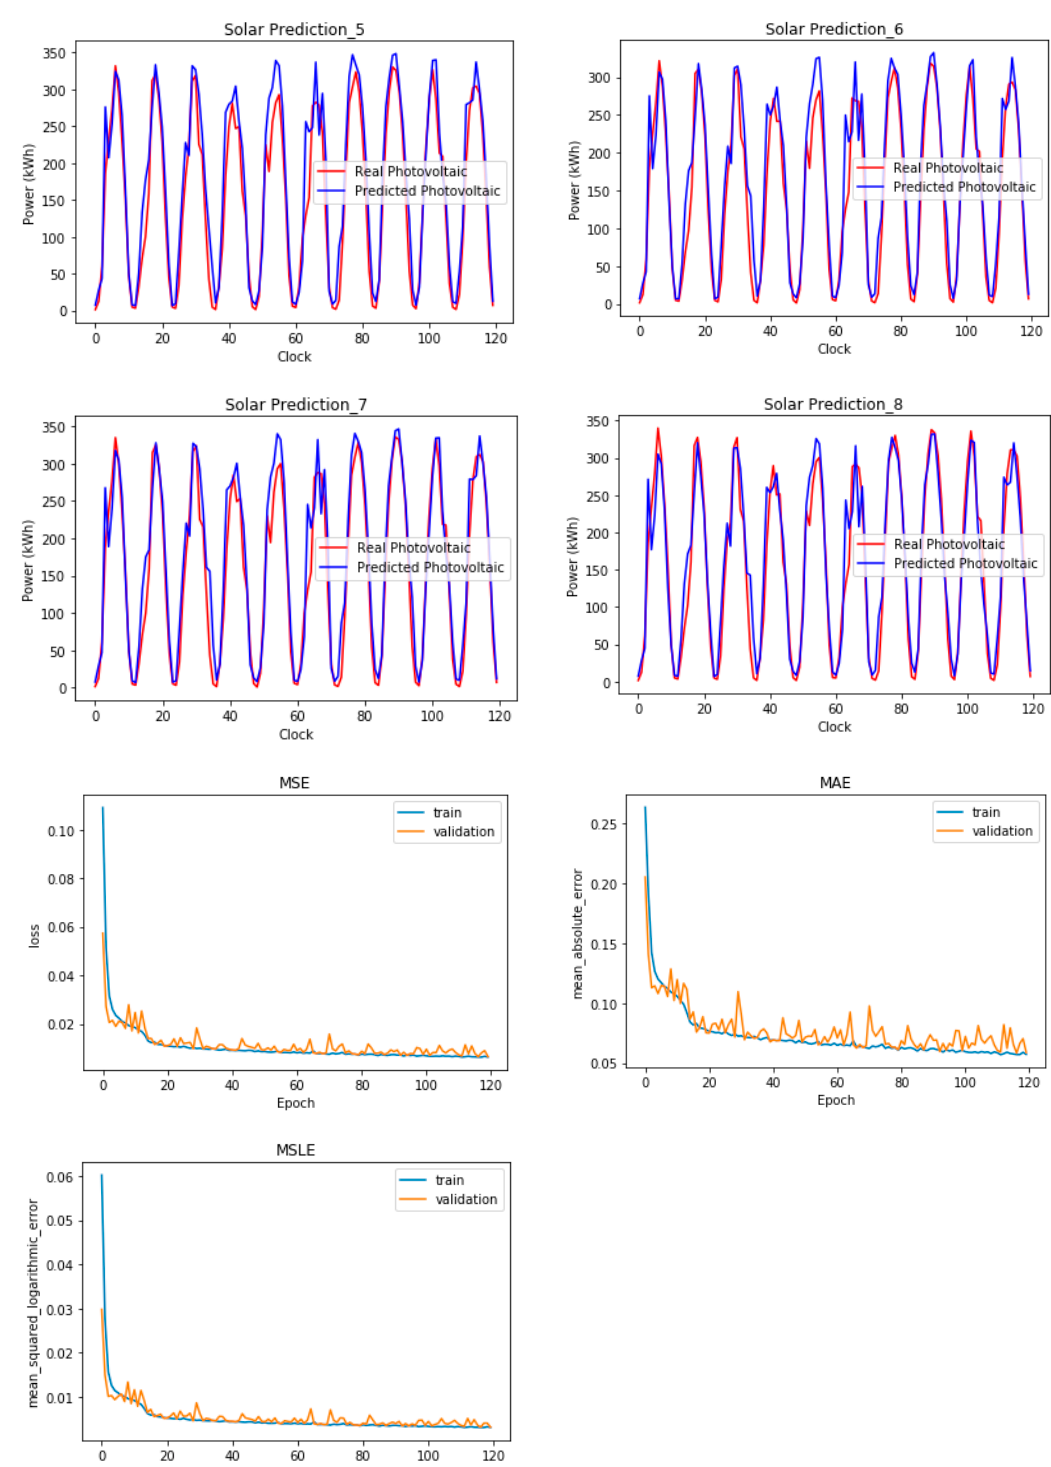
Figure 4. Multiple inverters and model predictions with the same A-11 feature variable information (GRU) .